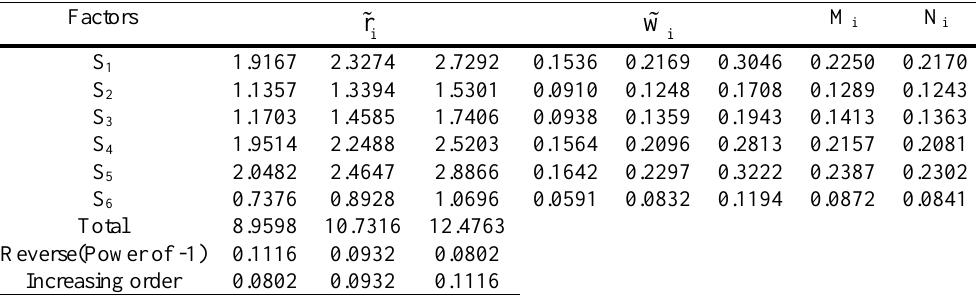
Table 10. Relative non-fuzzy and normalized weights of supplier chain.